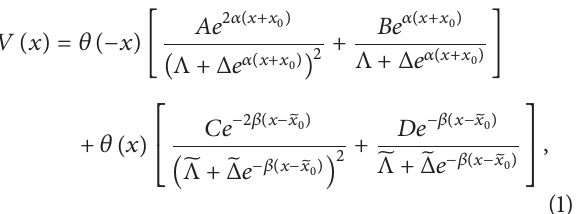
Hellmann-Feynman method. Qiang et al. have carried